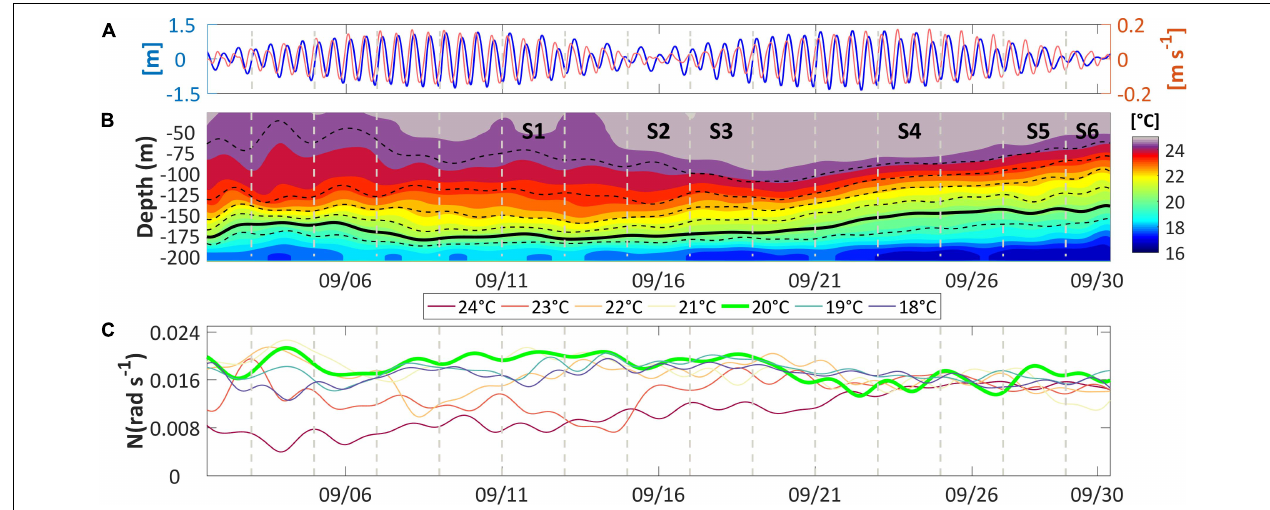
FIGURE 2 | (A) The tidal amplitudes (left axis) together with the tidal cross-slope barotropic currents (right axis) on PIL200, delayed of ∼ 13 h to represent the generation scenario. (B) The subinertial (low-pass-36-h filtered) temperature field, displaying the depth of isotherms from 19 to 24 ◦ C, and the 2-day segments (vertical gray dashed lines) which define the time intervals of interest (S1 to S6). The thick black line marks the 20 ◦ C isotherm. (C) The brunt–Väisälä frequencies corresponding to these